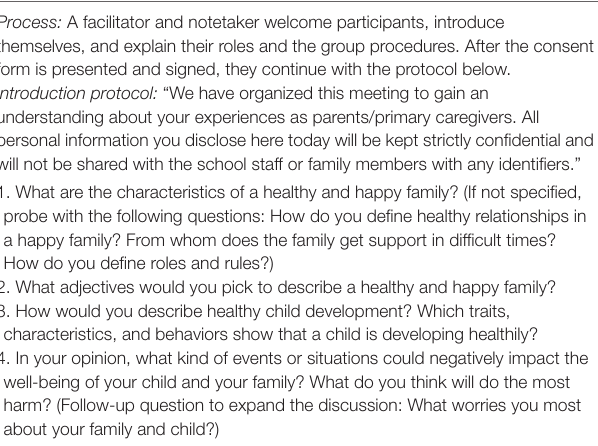
TABLE 2 | Focus group protocol and semi-structured interview